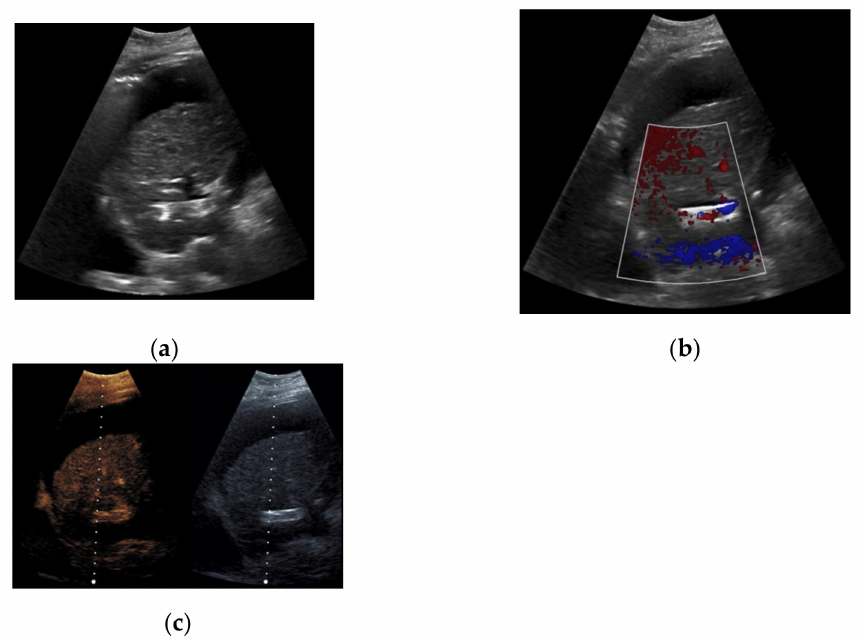
Figure 7. 52-year-old female patient with irregular presentation of the transjugular intrahepatic portosystemic shunt (TIPS) on B-mode ultrasound ( a ) and partial flow on Color Doppler ultrasound (CDUS) ( b ). After contrast administration, in contrast to CDUS, regular and continuous contrast of the TIPS is seen without evidence of thrombotic alterations or occlusion ( c ). Table 3. Depiction of the different findings during Color Doppler ultrasound and contrast-enhanced ultrasound. Color Doppler Ultrasound (Prior to Contrast-Enhanced Ultrasound)